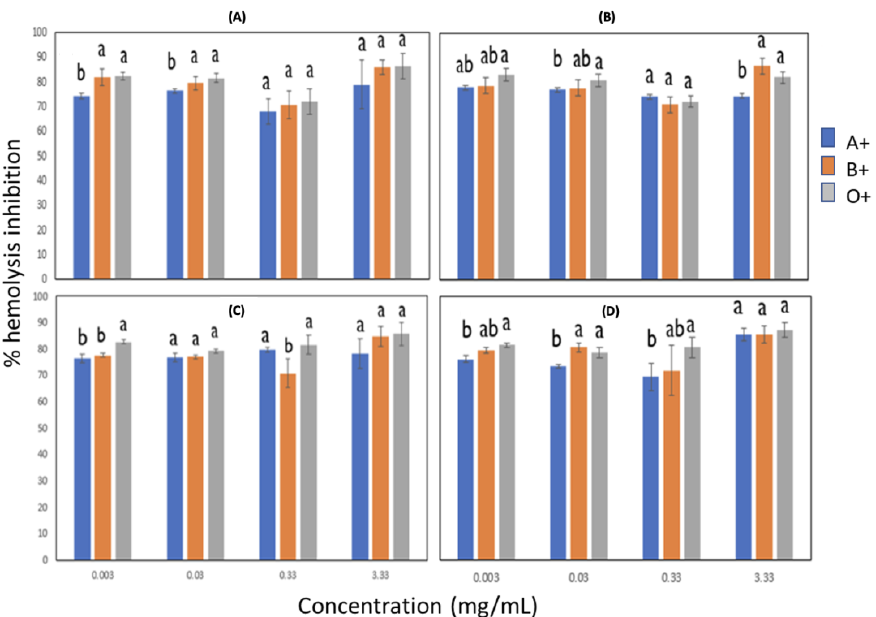
Figure 5. Effect of blood groups on anti-inflammatory activity due to hypotonicity in lignin with and without ultrasonic pulses. ( A ) Lignin with 0/0 time (min)/amplitude (MHz), ( B ) Lignin with 10/14 time (min)/amplitude (MHz), ( C ) Lignin with 10/18 time (min)/amplitude (MHz), ( D ) Lignin with 10/20 time (min)/amplitude (MHz). Different letters indicate significant difference ( p < 0.05).